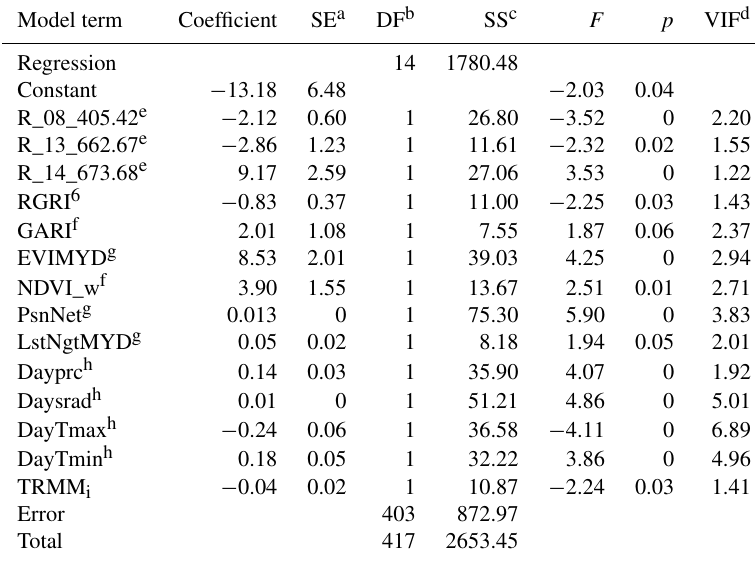
Table C1. Analysis of variance for GGP derived from EC data at the Bernal site. Variable details are described in Appendix